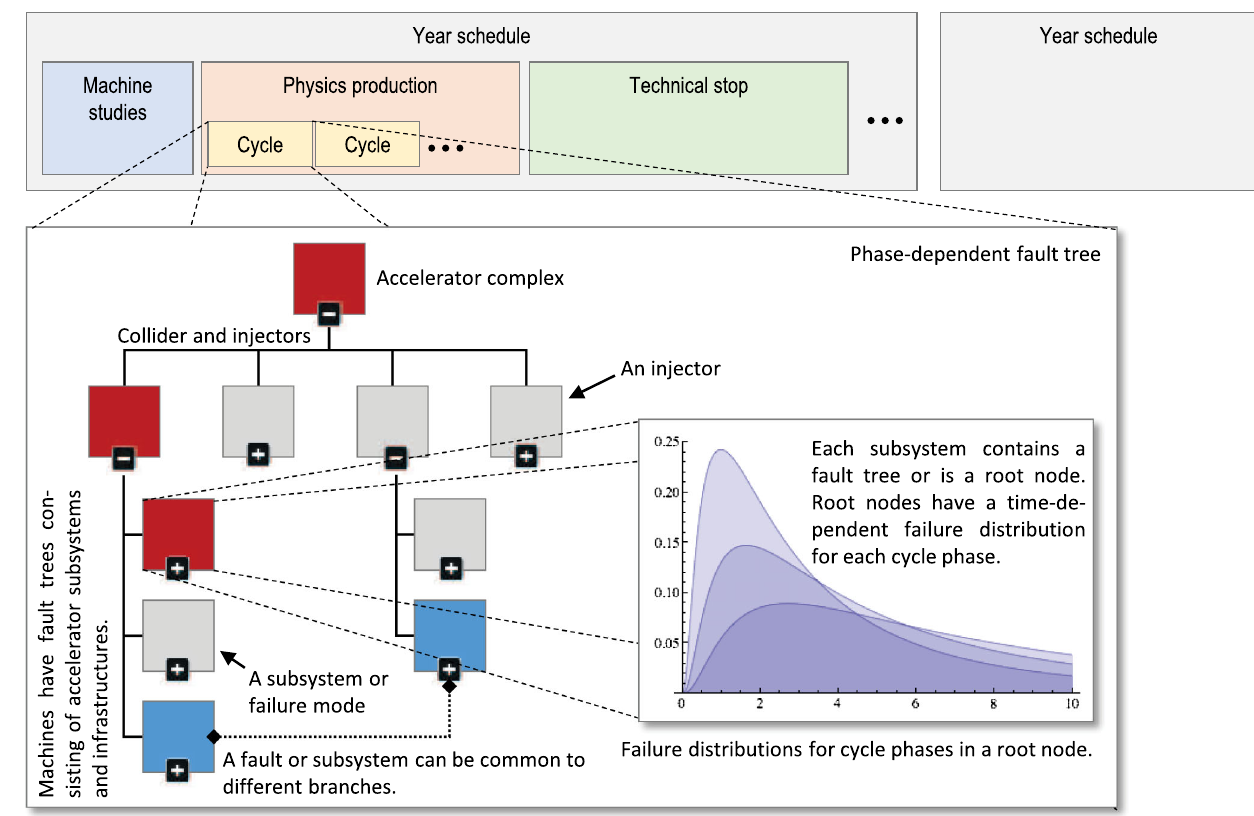
FIG. 8. The model concept with the main features.